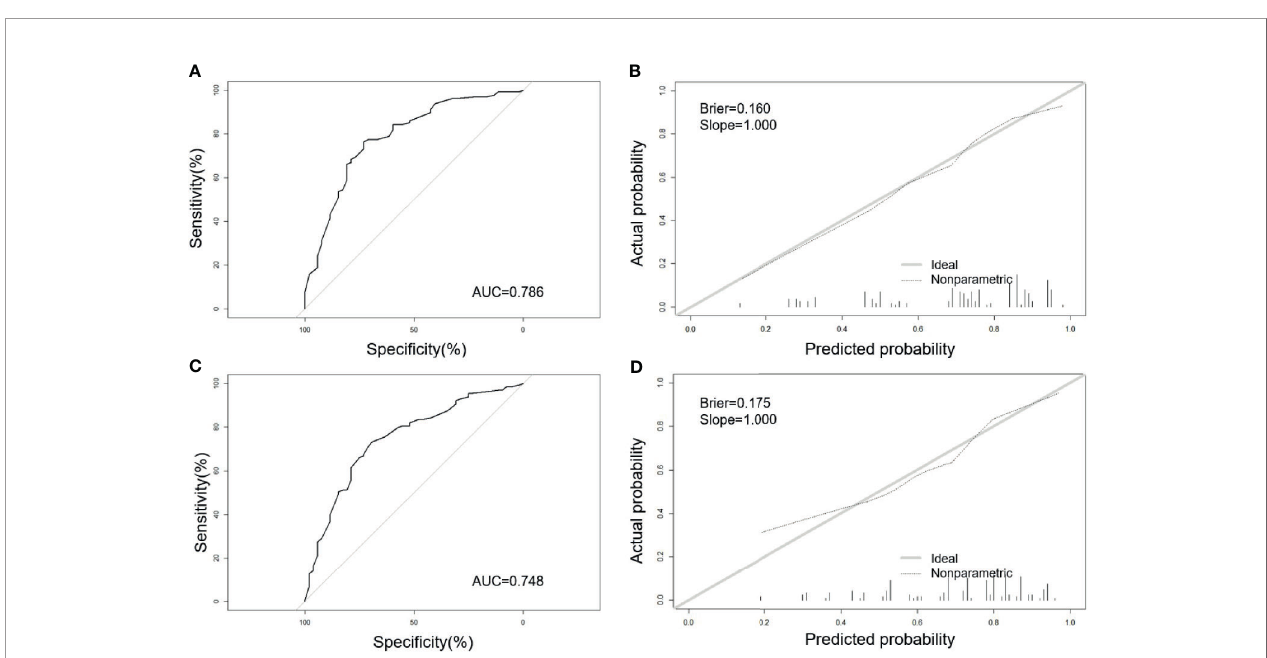
FIGURE 2 | Receiver operating characteristic (ROC) curves and calibration plots of the training and validation sets. (A) Area under the ROC curve (AUC) of the training set is 0.786 (95% CI: 0.710 – 0.861). (B) Calibration curve for training set (Brier = 0.160, Slope = 1.000). (C) AUC of the validation set is 0.748 (95% CI: 0.668 – 0.827). (D) Calibration curve for validation set (Brier = 0.175, Slope = 1.000). Calibration curves were used to evaluate the calibration of the model. The horizontal axis is the predicted probability provided by this model, and the vertical axis is the observed incidence of pregnancy failure. The ideal line with 45° slope represents a perfect prediction (the predicted probability equals the observed probability). The lower the Brier score for a set of predictions, the better the prediction calibration. When the slope was closer to 1.00, the prediction model had better calibration